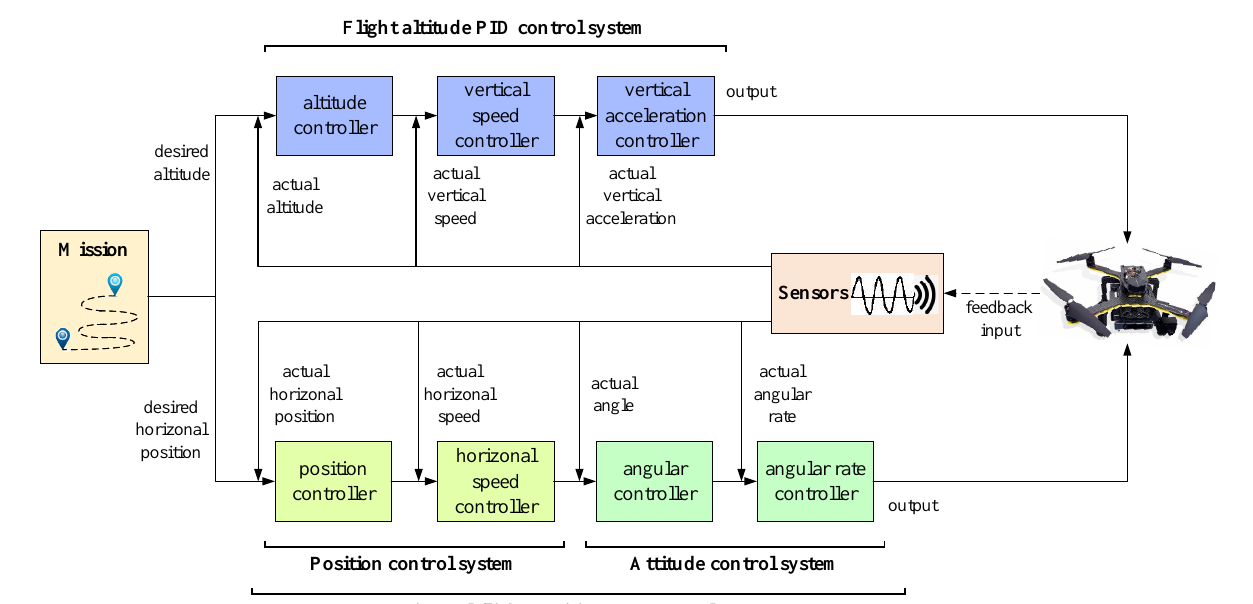
Figure 2. A UAV PID control